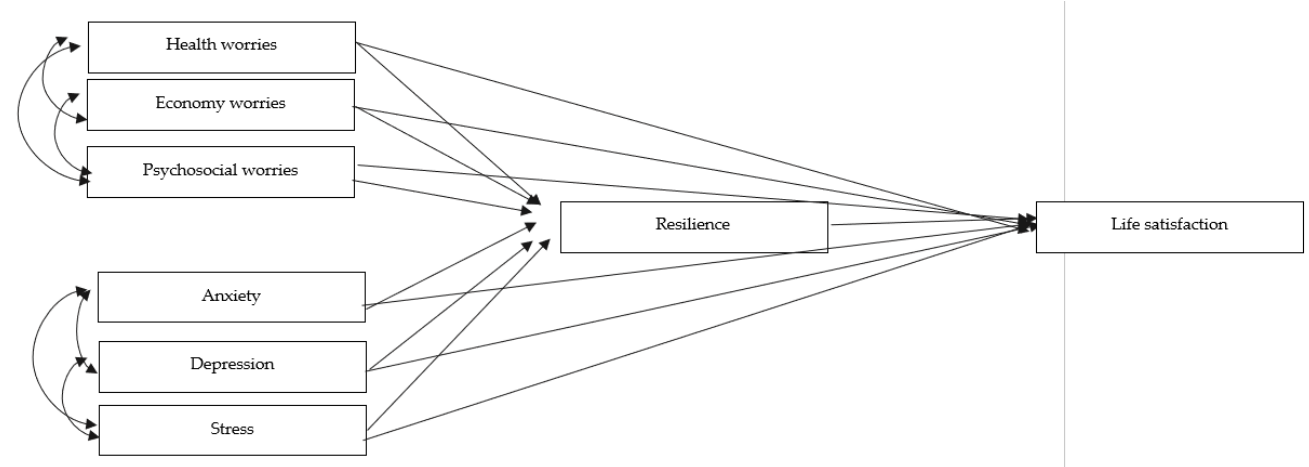
Figure 1. Theoretical model of causal relationships between dimensions of worries, dimensions of DASS, and resilience on life satisfaction.